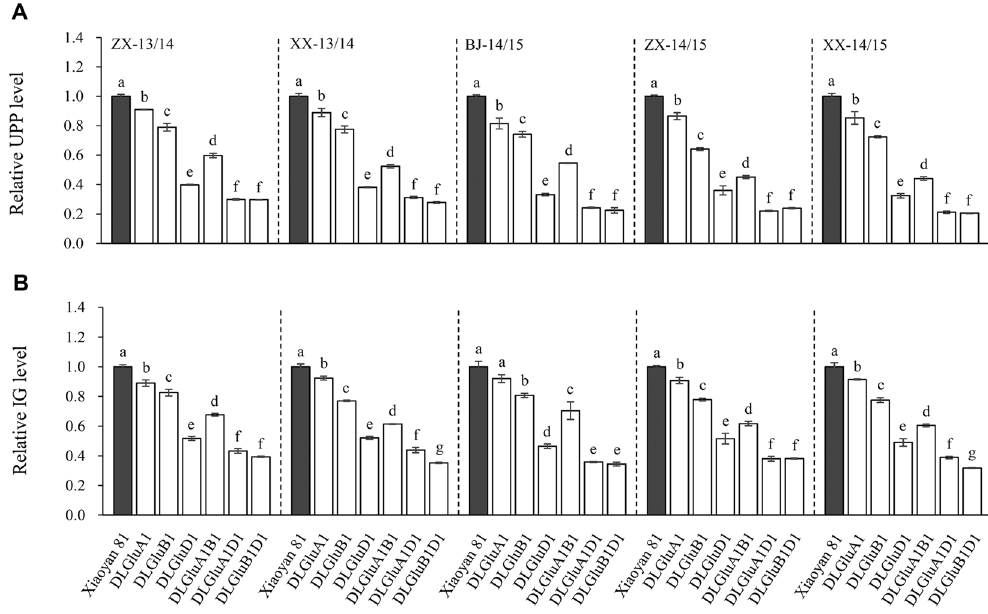
Figure 2. Decrease of UPP and IG in the six deletion mutants cultivated in five environments. The five environments were created by growing Xiaoyan 81 and the six deletion lines (DLGluA1, DLGluB1, DLGluD1, DLGluA1B1, DLGluA1D1 and DLGluB1D1) in two locations (ZX and XX) in 2013/2014 and three locations (BJ, ZX and XX) in 2014/2015. The values presented are means ± SE of three separate tests, with the UPP and IG levels of Xiaoyan 81 being set as 1 to facilitate comparisons. In each environment, the means marked by different letters are statistically significant ( P < 0.05). ( A ) Relative UPP levels in Xiaoyan 81 and the six deletion mutants. ( B ) Relative IG levels in Xiaoyan 81 and the six deletion mutants. BJ, Beijing; IG, insoluble glutenin; UPP, unextractable polymeric protein; XX, Xinxiang; ZX, Zhaoxian.